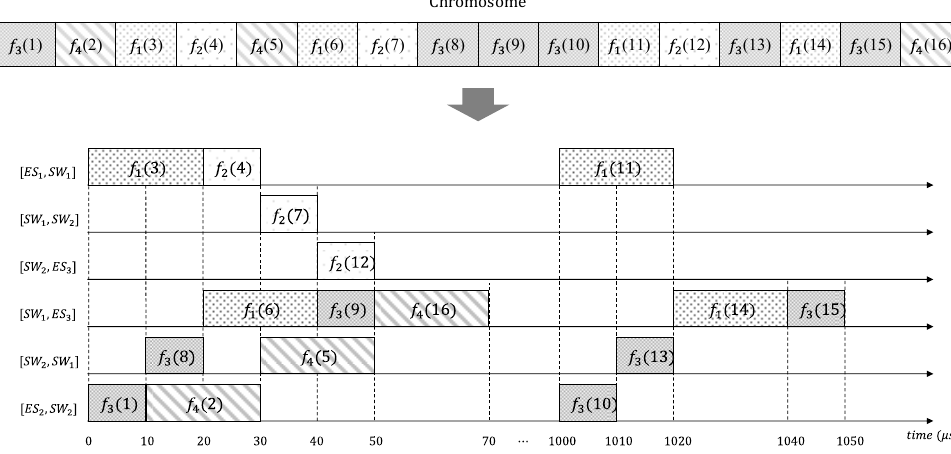
Figure 4. Case of schedule generated from chromosome in Gantt chart.